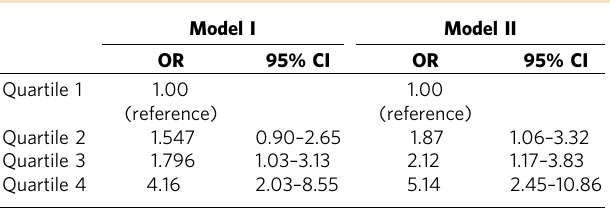
Table 2 | Association between the weighted genotype-risk score and